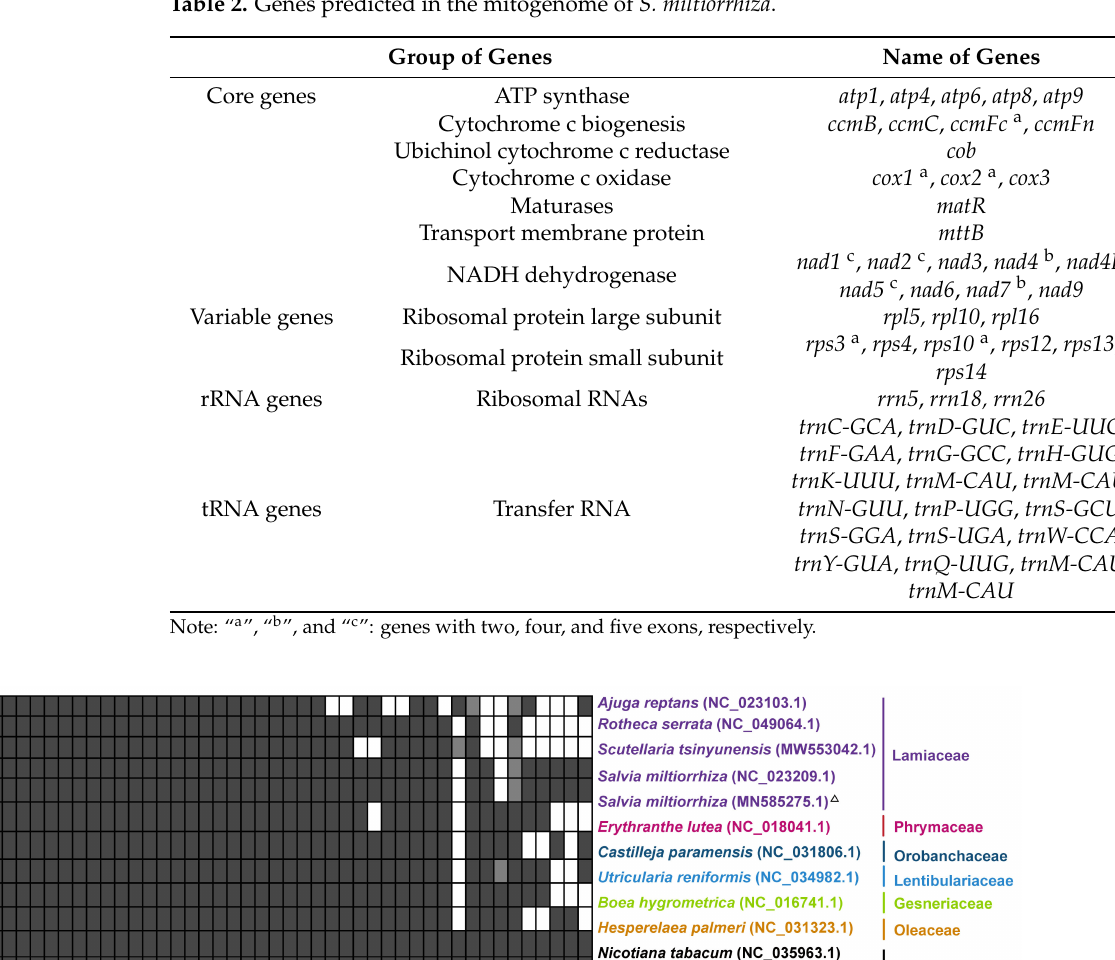
Table 2. Genes predicted in the mitogenome of S. miltiorrhiza .